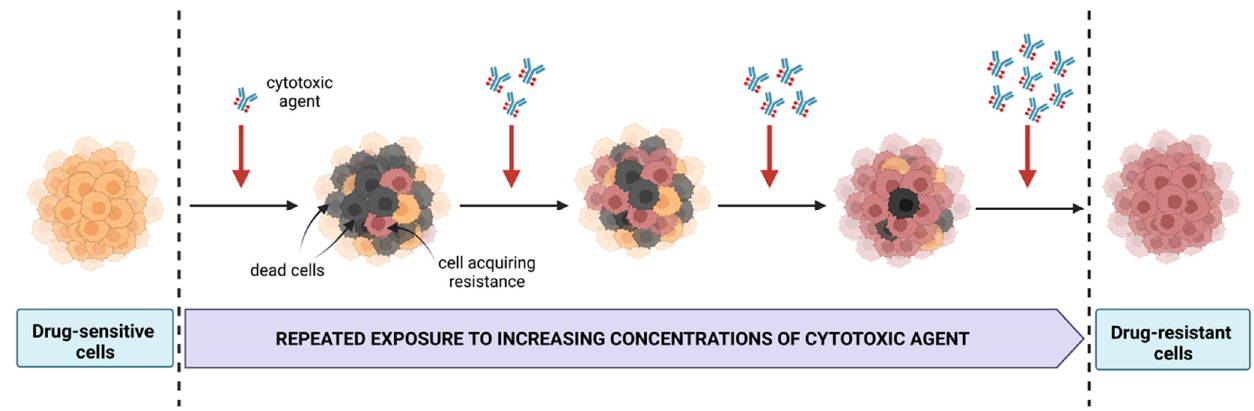
Figure 2. Generation of cell line models resistant to therapeutic agents. Created with BioRen- der.com, accessed on 30 October 2022. accessed on 30 October